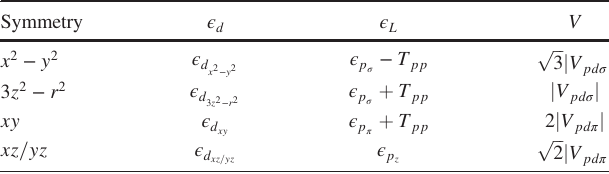
, ϵ , ϵ ) p σ p π p z